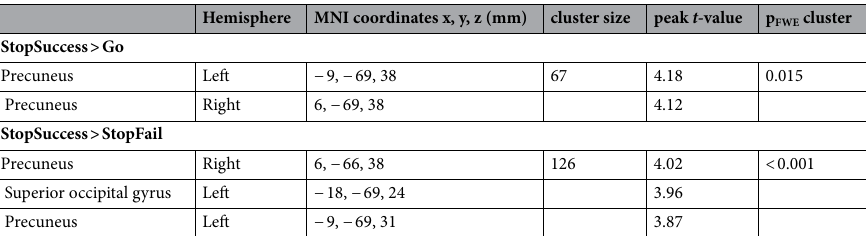
Table 3. Clusters (p FWE < 0.05) with their (sub-)peak coordinates showing a correlation between the absolute changes in brain activation during the stop-signal task and the relative ARS score decrease after following an FFD (n = 53). ARS attention-deficit hyperactivity disorder (ADHD) rating scale, FFD few-foods diet, MNI coordinates Montreal Neurological Institute stereotaxic coordinates, p FWE -value family-wise-error-corrected p value. Sub-peaks are